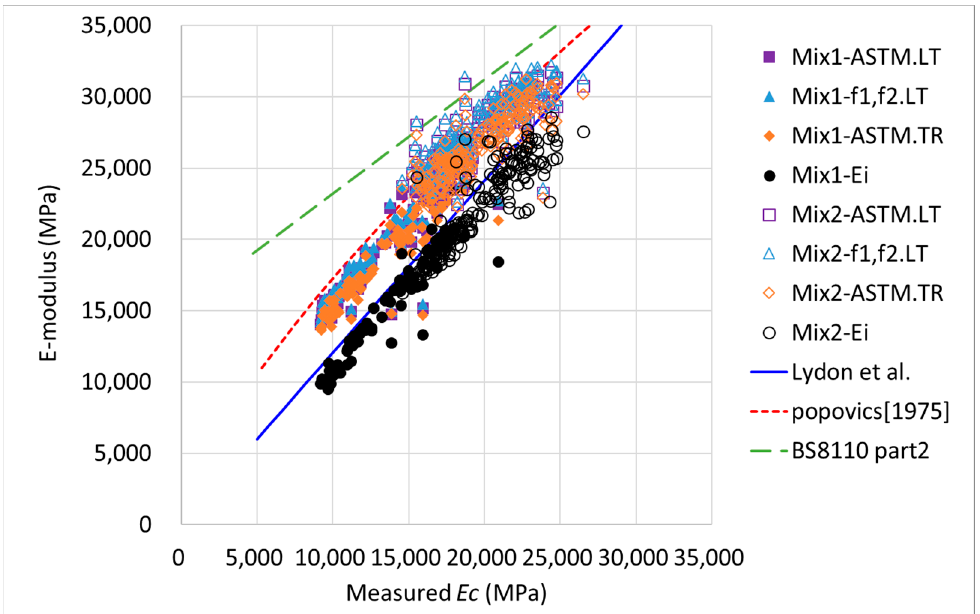
Figure 7. Comparison of static elastic modulus ( Ec ), Ei , and dynamic elastic modulus ( Ed ). Table 4. Correlation between static elastic modulus ( Ec ) and E-modulus.